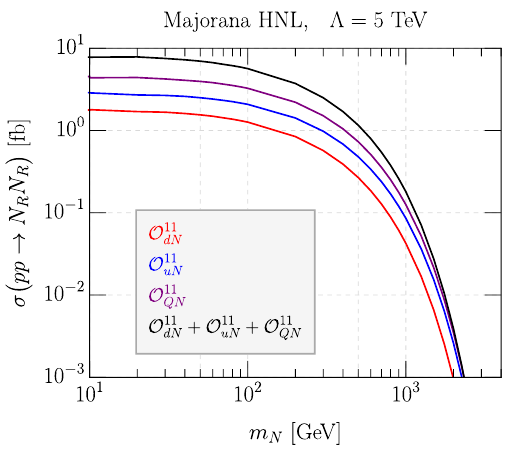
Figure 3 . Cross sections for pair production of HNLs N R as function of m N . The plot compares different operators. For the single-operator calculation, only one coefficient has been chosen non- zero. For the three-operator calculation all c 11 with q = d, u, Q , are set to one simultaneously. qN This example is for a scale of Λ = 5